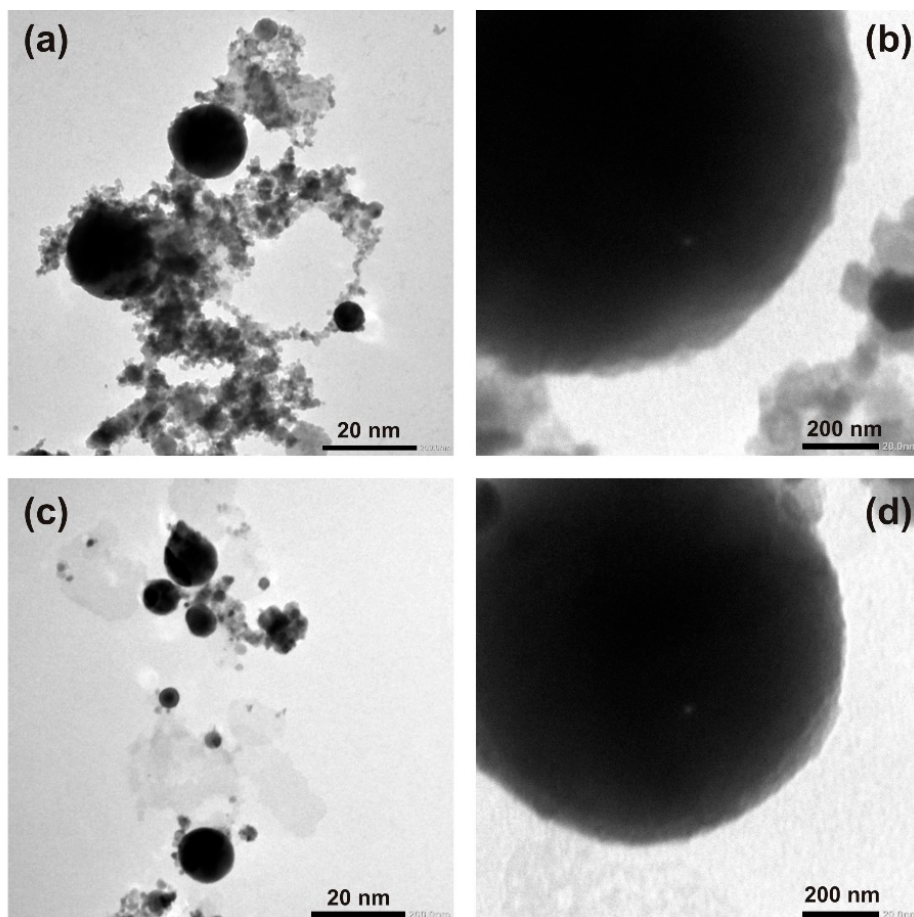
Figure 3. TEM images of pure ZnO NP ( a , b ) and Ag-doped ZnO NP ( c , d ).